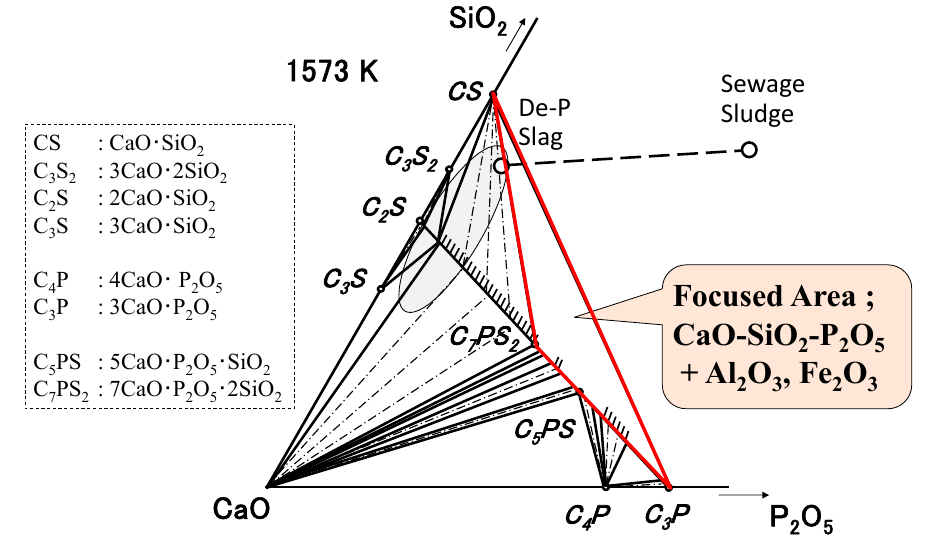
Figure 1. Isothermal section of the CaO-SiO 2 -P 2 O 5 ternary phase diagram at 1573 K.